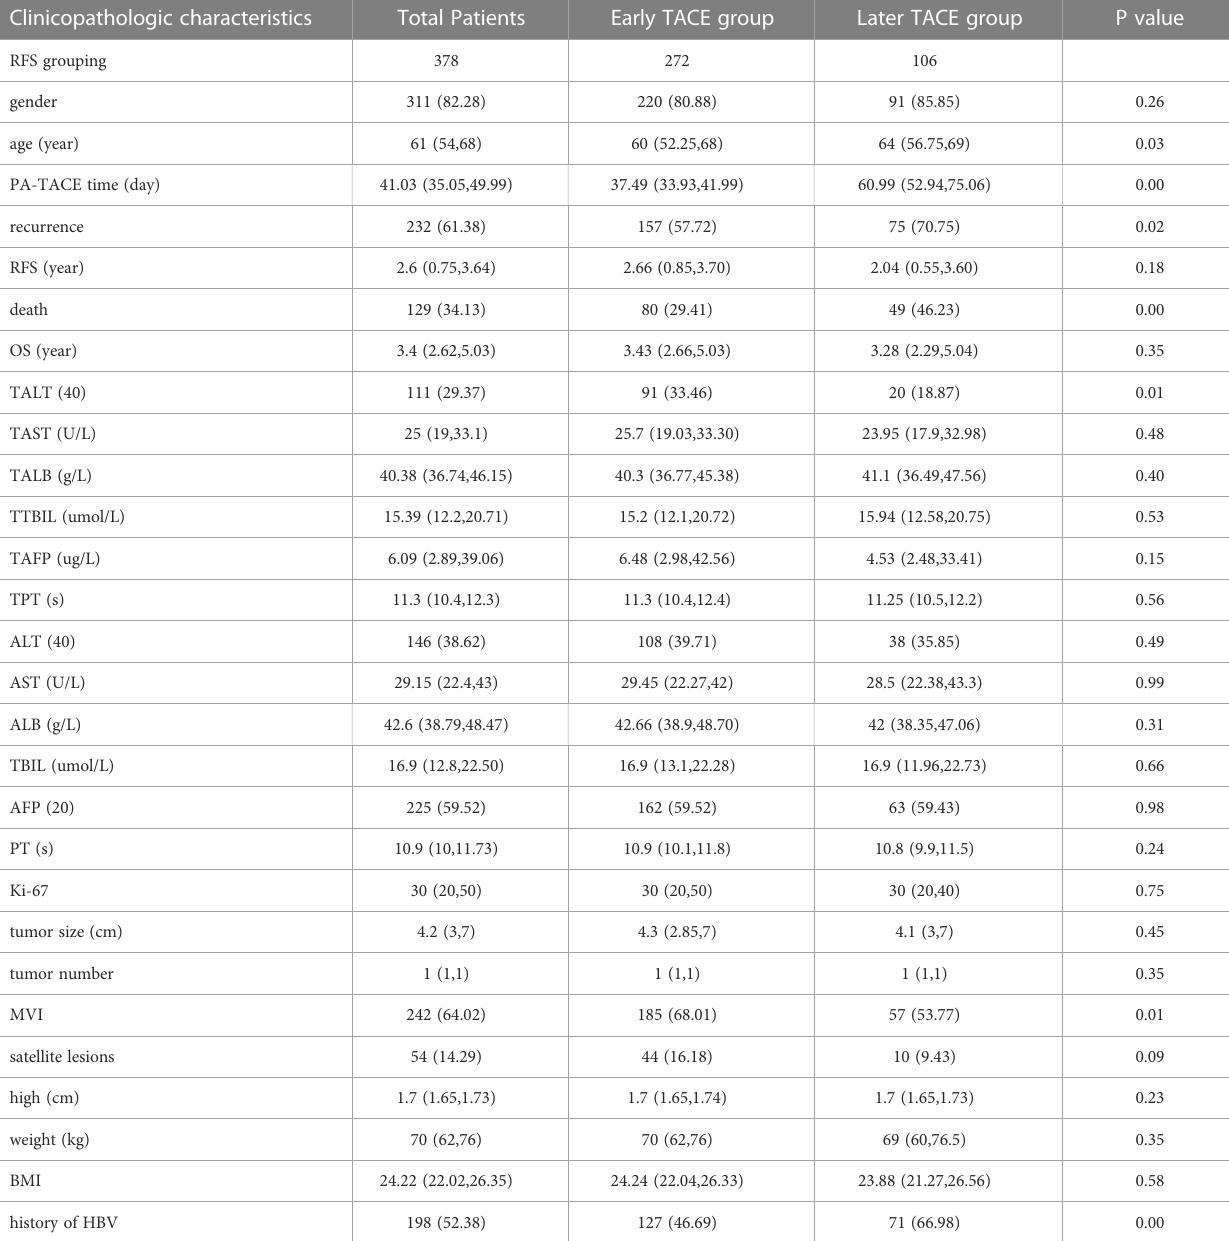
TABLE 2 The clinicopathologic characteristics of the HCC patients in training